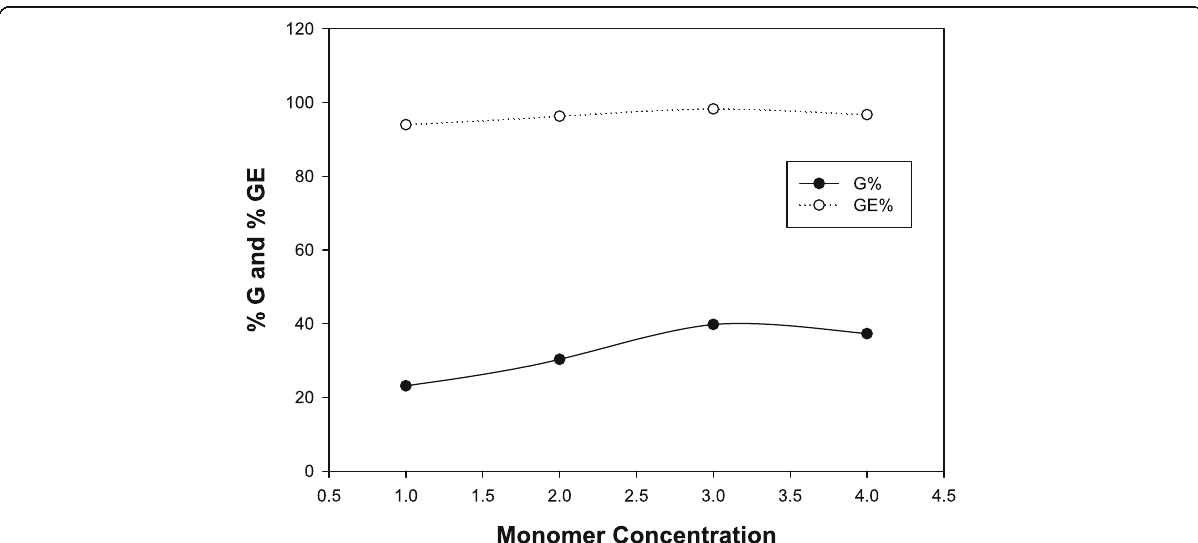
Fig. 2 Effect of monomer concentration on grafting percentage (%G) and grafting efficiency (%GE) (Reaction conditions: 1 g CMCh, [APS]=0.6 g, time 2 h, temperature 60